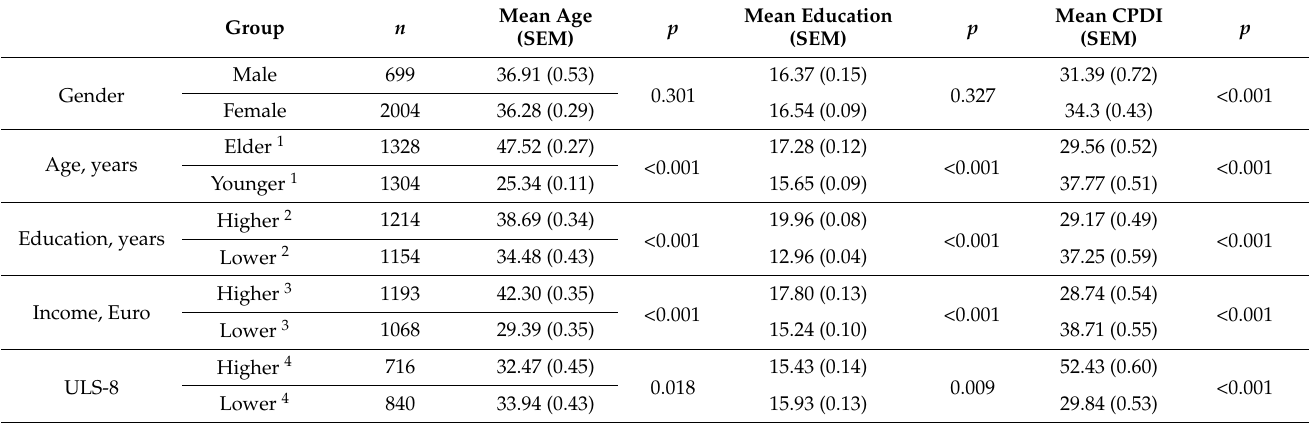
Table 1. Participants’ sociodemographic variables and group comparisons.